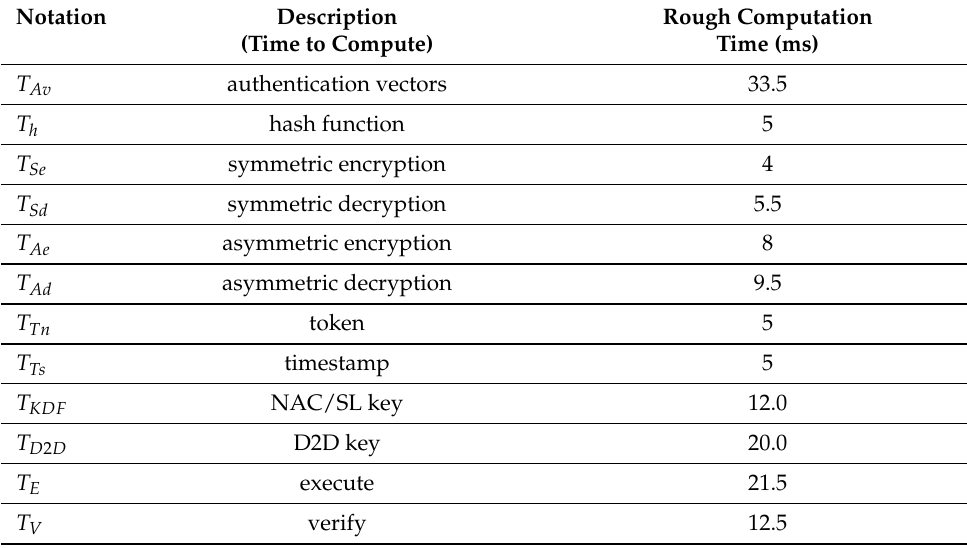
Table 5. Approximate Time for Cryptographic